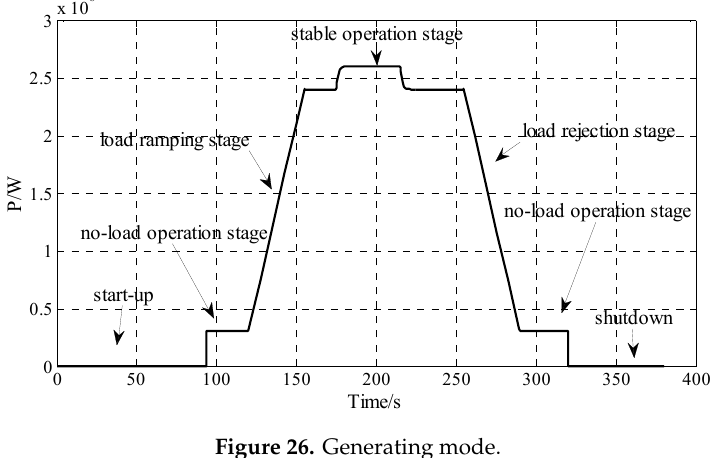
Figure 26. Generating mode. Appl. Sci. 2019 , 9 , x FOR PEER REVIEW